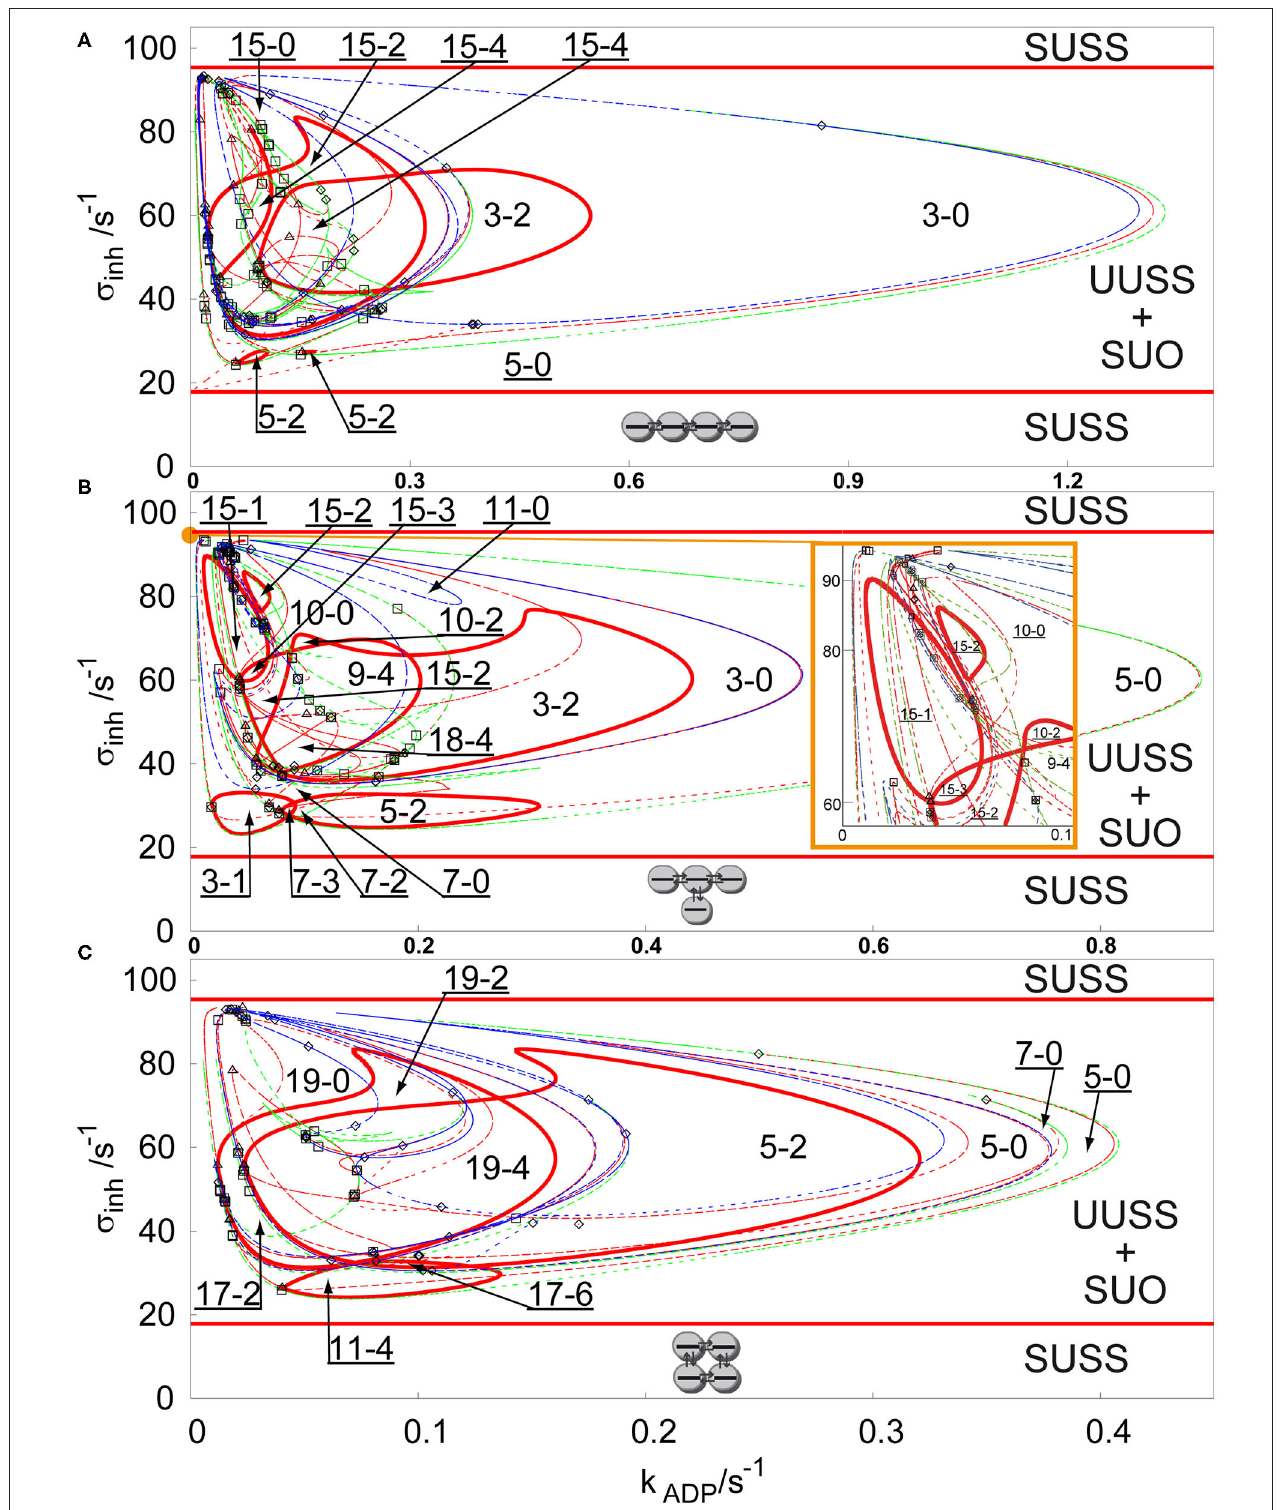
FIGURE 2 | Comparison of bifurcation diagram four coupled cells in a parameter plane σ inh and k ADP , q = 1, σ M = 100 s − 1 in: (A) linear array, (B) T-shaped array, (C) cyclic array. Red curve—Hopf bifurcation curve; blue curve—symmetry breaking bifurcation curve; green curve—limit point curve; full line—change of stability across